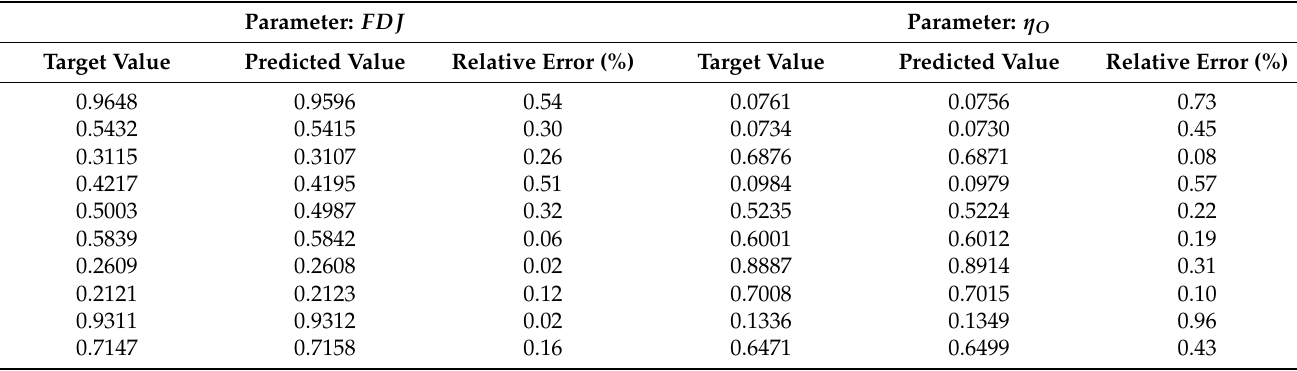
Table 6. Validation for Case B. Ten randomly predicted values were confronted with their actual value (“Target value”) in order to calculate the relative error of the